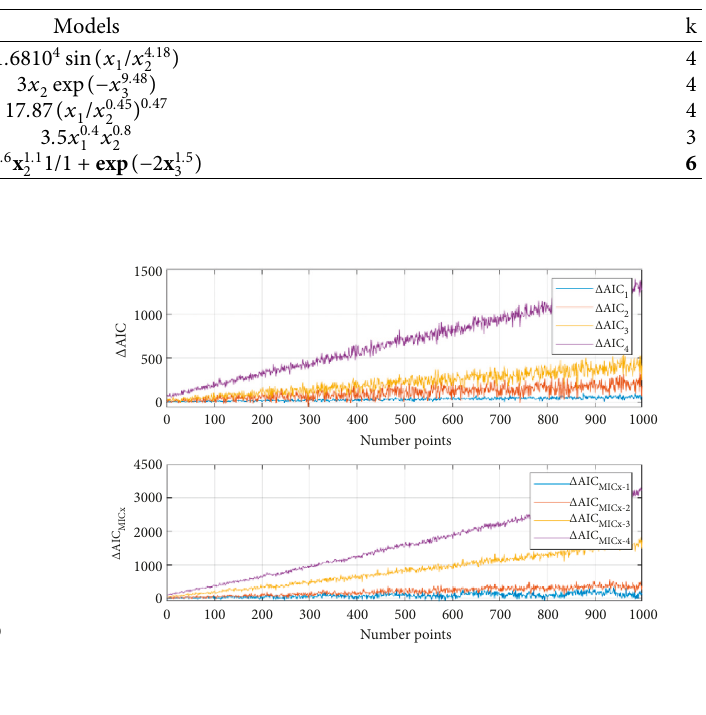
Table 3: Power law plus a squashing term.